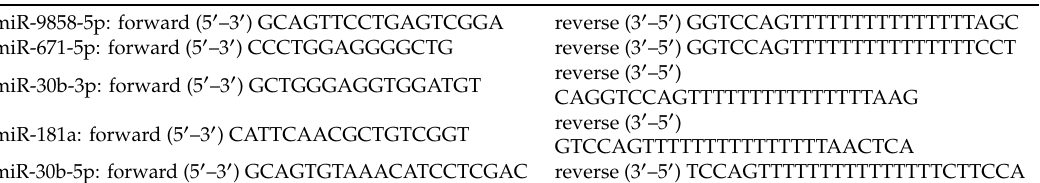
Table 2. Primers used for miRNAs validation 1